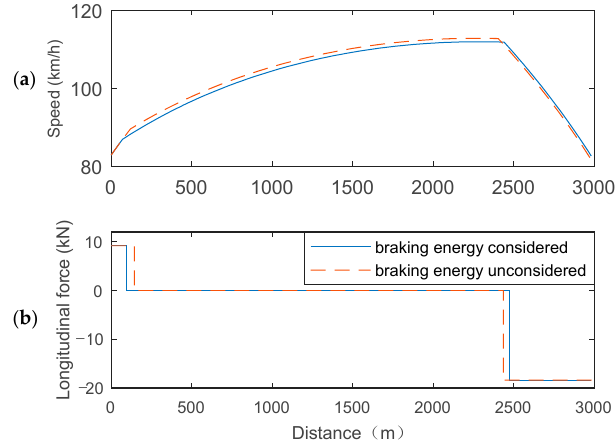
Figure 9. Optimum speed profile and its corresponding control inputs; time factor σ = 0~38, duration t f = 107 s/107 s. ( a ) Speed profile; ( b ) control input profile.